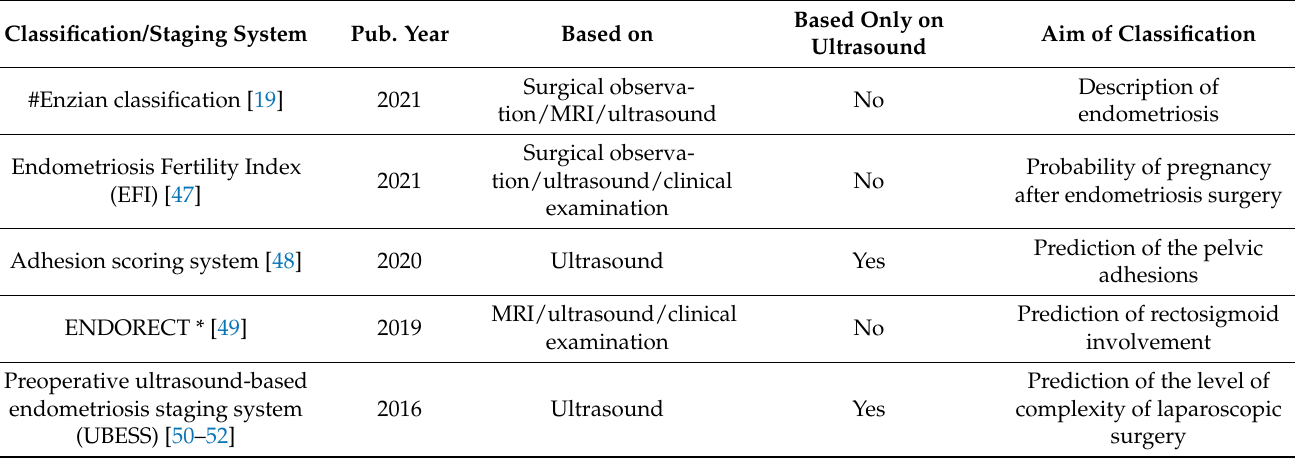
Table 1. The different and more recent endometriosis classification/staging system based on